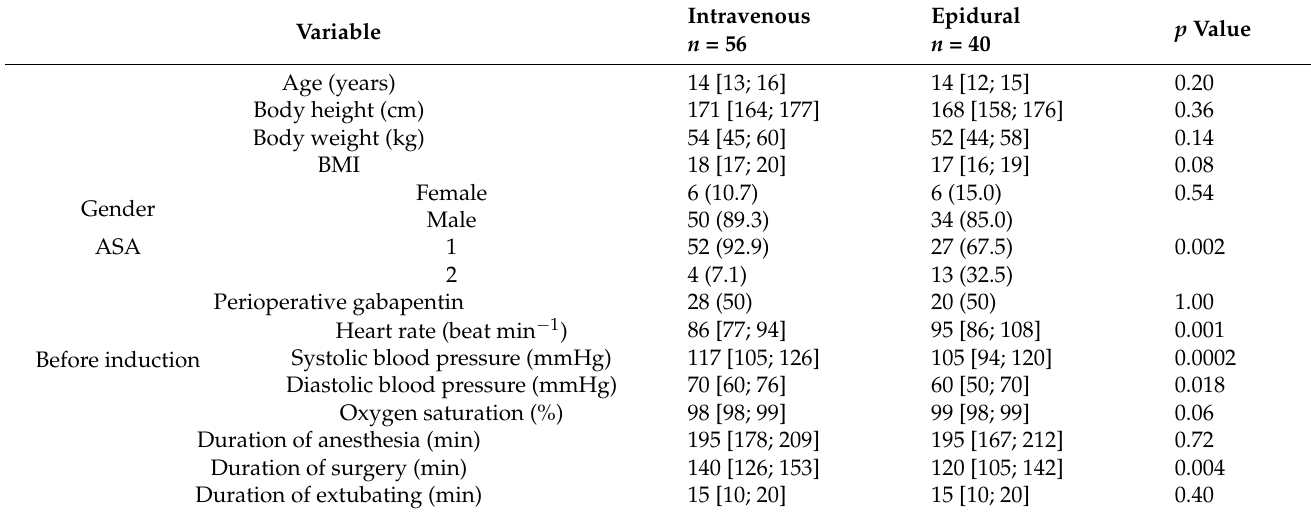
Table 2. Demographic and clinical data in the intravenous and epidural groups.